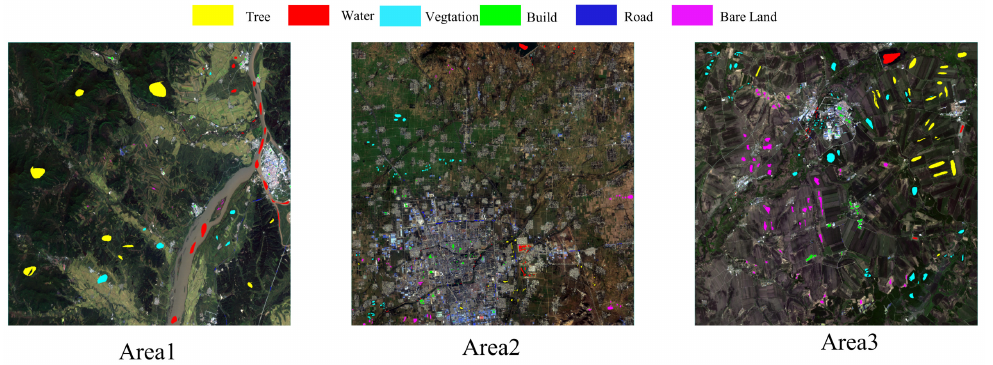
Figure 6. Distribution of the selected sample objects in